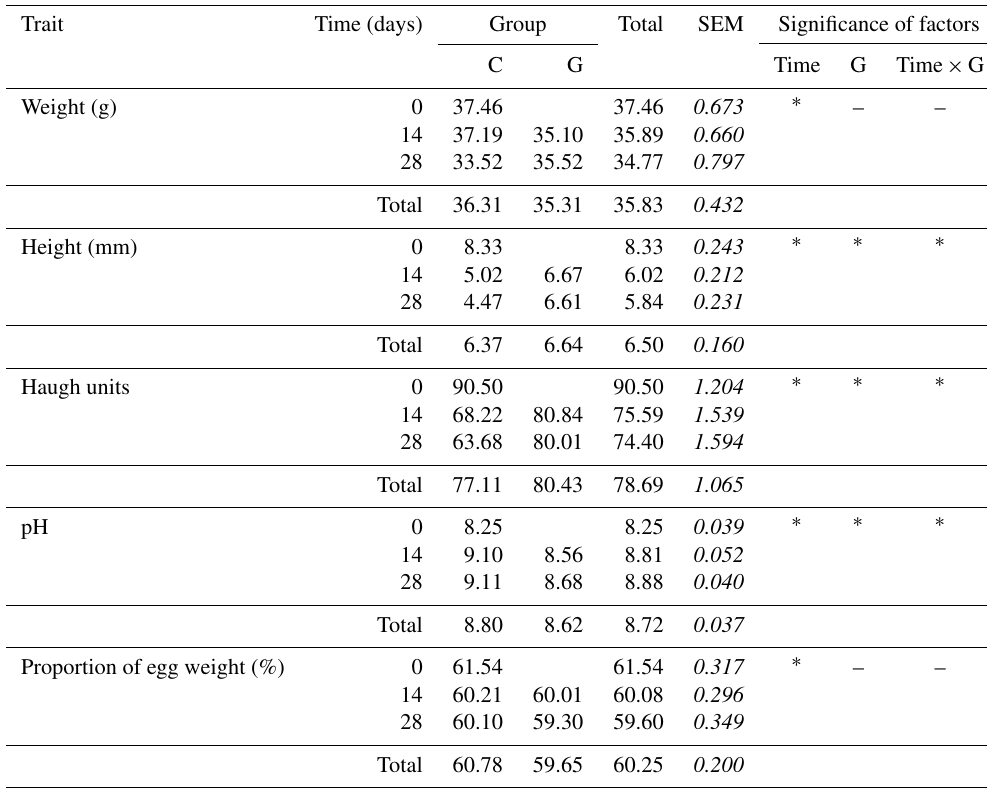
Table 4. Traits of egg albumen in the control and experimental groups.